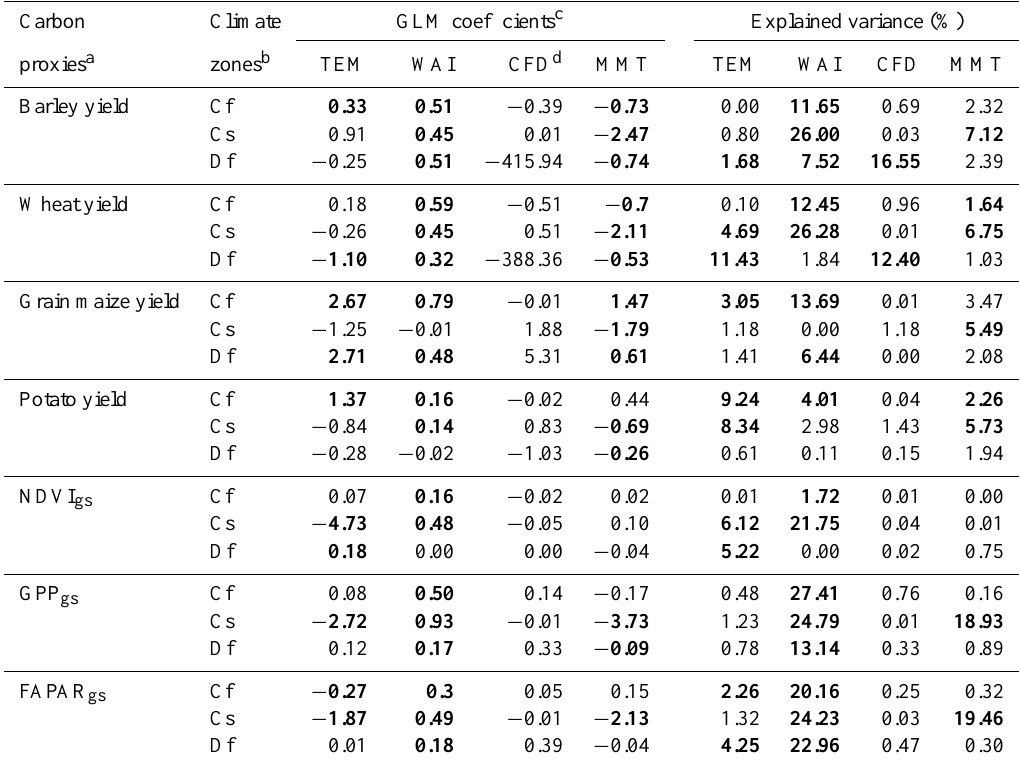
Table 1. Generalized linear model analyses for the relationships between productivity proxies and climate in different climate zones. Carbon Climate GLM coefficients c Explained variance (%) proxies a zones b Barley yield